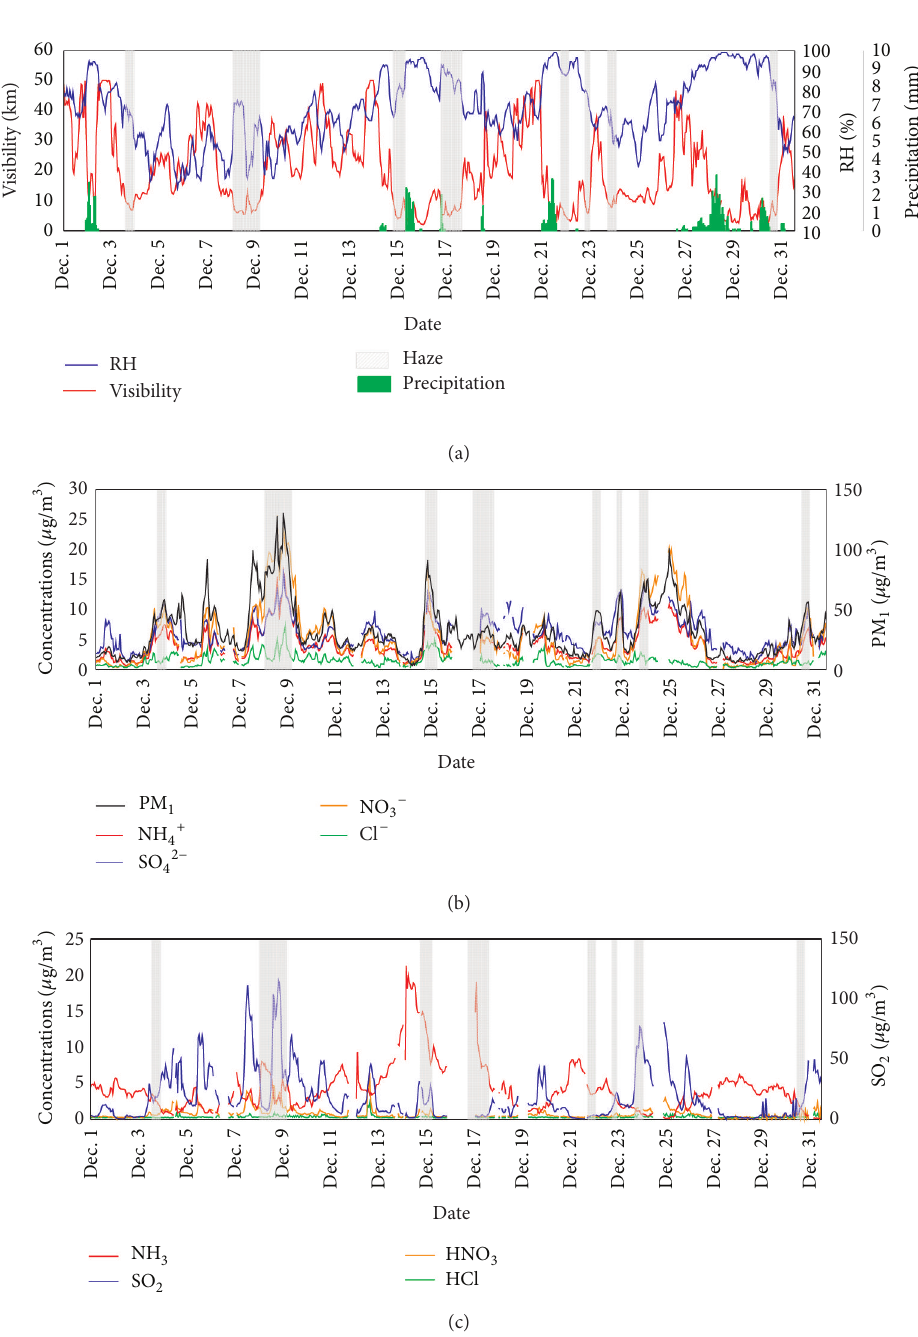
Figure 2: Time series of (a) visibility (km), RH (%), and precipitation (mm/h), (b) mass concentration ( 𝜇 g/m 3 ) of PM 1 and SIA species ( NH 4+ , SO 42− , NO 3− , and Cl − ), and (c) mass concentration ( 𝜇 g/m 3 ) of precursor gasses (NH 3 , HNO 3 , SO 2 , and HCl) during the study period (December 1–31, 2012) in Shanghai. Gray hatched frames represent the 8 haze episodes.